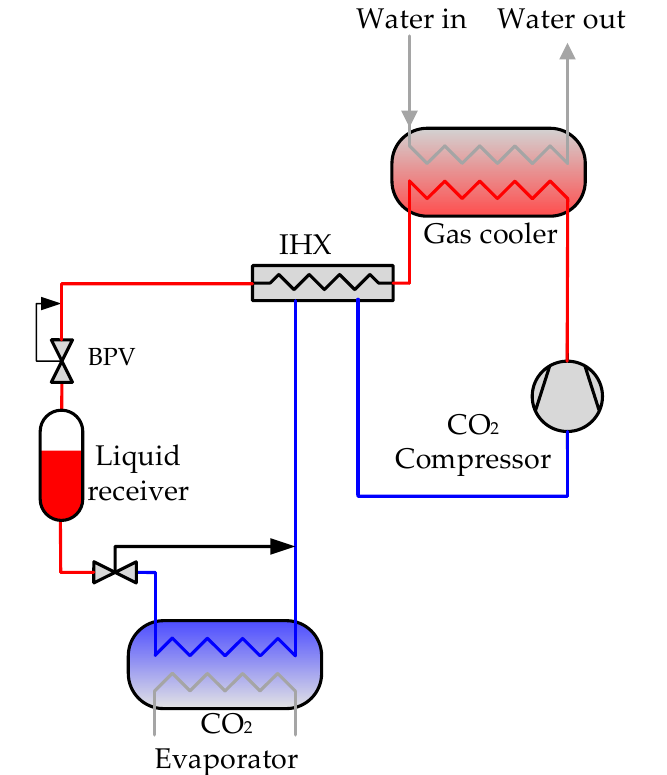
Figure 1. Basic water source, transcritical CO 2 heat pump with IHX configuration analyzed for hot water generation.